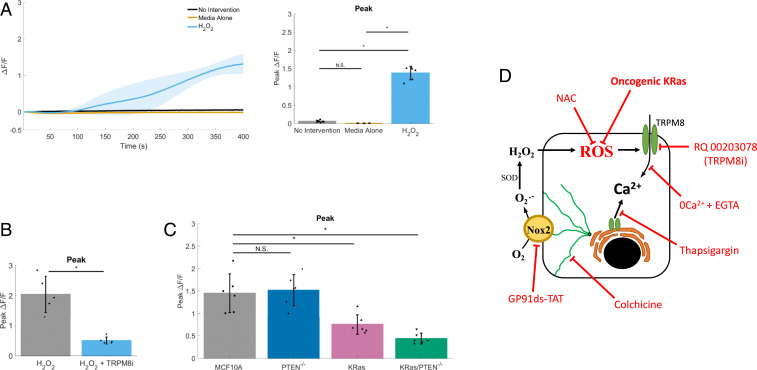
ROS activates calcium signaling through TRPM8, but ROS sensitivity is inhibited in KRas mutant cells. (A) Traces show reactive oxygen species (ROS)-stimulated calcium signaling (ΔF/F) plotted over time. Bar graph shows quantification of peak ΔF/F. During imaging, 1 mL of 20 mM hydrogen peroxide (positive control for ROS, “H2O2”) was added to cells containing 1 mL of media (final H2O2 concentration, 10 mM) and compared to either addition 1 mL of media (“Media Alone”) or no intervention (“No Intervention”). Addition of H2O2 resulted in a gradual increase in intracellular calcium, compared to negative controls. Data are presented as mean ± SD. The asterisk (*) indicates significance from control, P < 0.05 via paired t test. N.S. indicates no significant difference. Data represent n = 6 in total from six independent experiments for each group. (B) Bar graph shows quantification of peak ΔF/F. During imaging, 1 mL of 20 mM hydrogen peroxide (positive control for ROS) was added to cells containing 1 mL of control media (H2O2) or 25 µM RQ-00203078, a potent and selective TRPM8 antagonist (H2O2 + TRPM8i) (final H2O2 concentration, 10 mM). Addition of H2O2 in RQ-00203078–treated cells showed a reduced peak (ΔF/F) ROS-induced calcium compared with controls. Data are presented as mean ± SD. The asterisk (*) indicates significance from control, P < 0.05 via paired t test. Data represent n = 6 in total from six independent experiments for each group. (C) Bar graph shows quantification of peak ΔF/F, for ROS-stimulated intracellular calcium (ΔF/F) over time in human breast epithelial cells (MCF10A), MCF10A PTEN null mutant cells (PTEN−/−), MCF10A constitutively active KRas(G12V) mutant cells (KRas), or MCF10A combination mutant cells (KRas/PTEN−/−). Compared with control MCF10A parental cells, addition of H2O2 resulted in a significantly reduced ROS-stimulated intracellular calcium in KRas or KRas/PTEN−/− mutants. Data are presented as mean ± SD. The asterisk (*) indicates significance, which was set at P < 0.05 via one-way ANOVA with a post hoc Tukey’s honest difference criterion. N.S. indicates no significant difference. Data represent n = 6 in total from six independent experiments for each group. (D) Graphic summarizes data showing mechanisms of mechanically induced X-ROS signaling in normal breast MCF10A epithelial cells. Cell damage-independent mechanical stimulation on low elastic modulus dishes (mSLED) mechanically stimulates microtubules to activate NADPH oxidase 2 (NOX2), which generates reactive oxygen species (ROS). ROS in turn acts on calcium channels such as TRPM8 to sustain long-term (persistent) mechanically activated calcium. However, overexpression of a constitutively active KRas oncogene inhibits the responsiveness to mechanical stimulation by reducing the ability of cells to respond to the ROS component of the signaling pathway. Pharmacological inhibitors or oncogenic activation used to elucidate mechanism are shown in red. The arrows indicate positive action or induction. The bar-headed lines indicate inhibition. 0Ca2+ + EGTA, depletes extracellular calcium and effectively inhibits calcium flux across the plasma cell membrane; colchicine, binds α-tubulin to effectively depolymerize microtubules; GP91ds-TAT, inhibitory peptide against NOX2; H2O2, hydrogen peroxide, positive control for ROS; NAC, N-acetylcysteine, an antioxidant or ROS negative control; oncogenic KRas, overexpression of activated KRas (G12V) in normal MCF10A cells; RQ-00203078/TRPM8i, a potent and selective transient receptor potential cation channel subfamily M member 8 (TRPM8) antagonist; thapsigargin, binds sarco/endoplasmic reticulum Ca2+-ATPase (SERCA) and effectively depletes intracellular calcium and inhibits calcium flux from the endoplasmic reticulum.